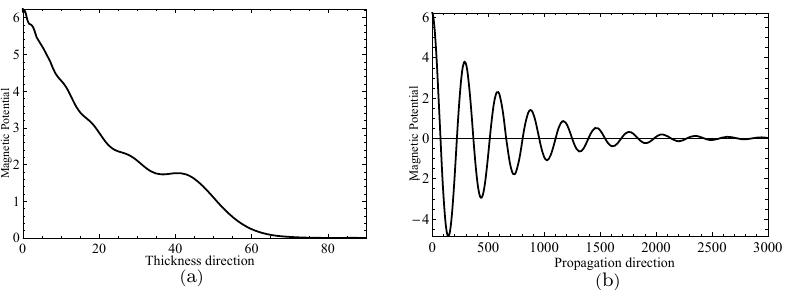
Figure 14. Magnetic potential distributions for thickness direction in ( a ) and propagation direction in ( b ) when f = 24.07 Hz, ξ = 2.1365 + 0.1694 i